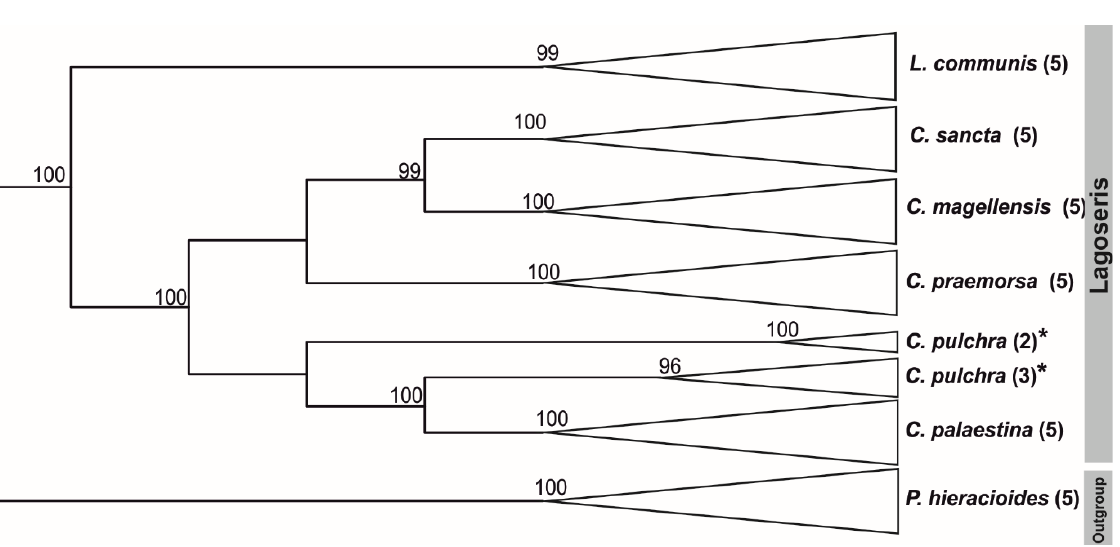
Figure 1. Phylogenetic analysis of cloned sequences of the 5S rDNA non-transcribed spacer repre- senting species of Lagoseris lineage. Numbers in parentheses indicate the number of analysed clones. The tree was rooted with Picris hieracioides . Bootstrap scores are shown above branches. The stars indicate species with two variants of 5S rDNA NTS.